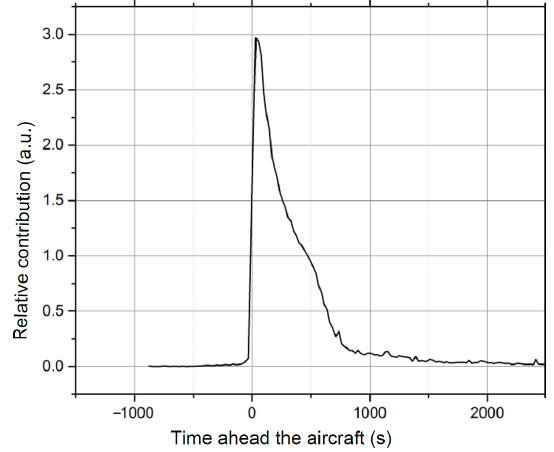
Figure 10. Relative contribution to the analyzed light as function of the time ahead of the actual flight position, as predicted by 3- D simulation of the radiative transfer for typical flight conditions (Raecke, 2013). The small random variations past 600s are due to the statistical nature of the Monte Carlo RTM, which introduce ran- dom uncertainties.